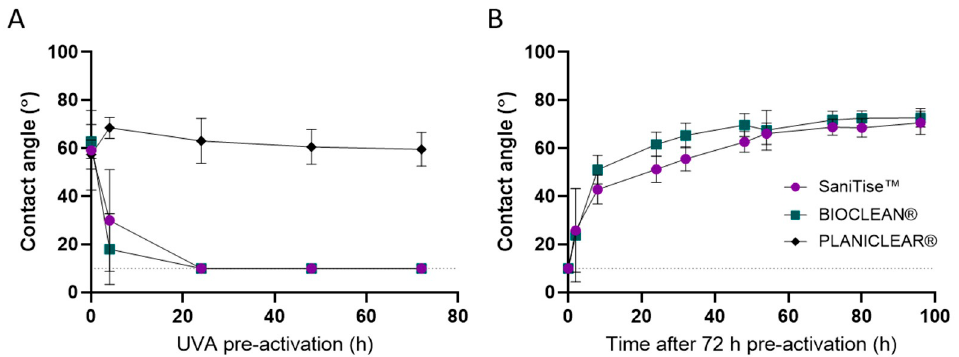
Figure 4. Time and treatment-dependent changes in hydrophilicity of the glass surfaces according to contact angle measurements: ( A ) contact angle variation after pre-activation with high-intensity (22–25 W/m 2 ) UVA; ( B ) contact angle recovery in dark conditions (note that PLANICLEAR ® control glass was not measured as there was no change in contact angle according to ( A )). Dotted line rep- resents immeasurable contact angle value (10°), below which the surfaces were considered super- hydrophilic.